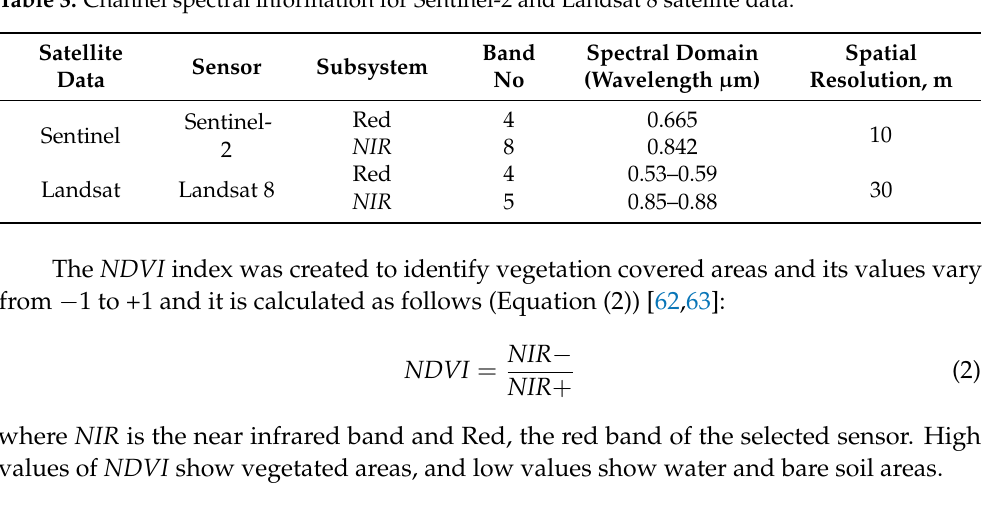
Table 3. Channel spectral information for Sentinel-2 and Landsat 8 satellite